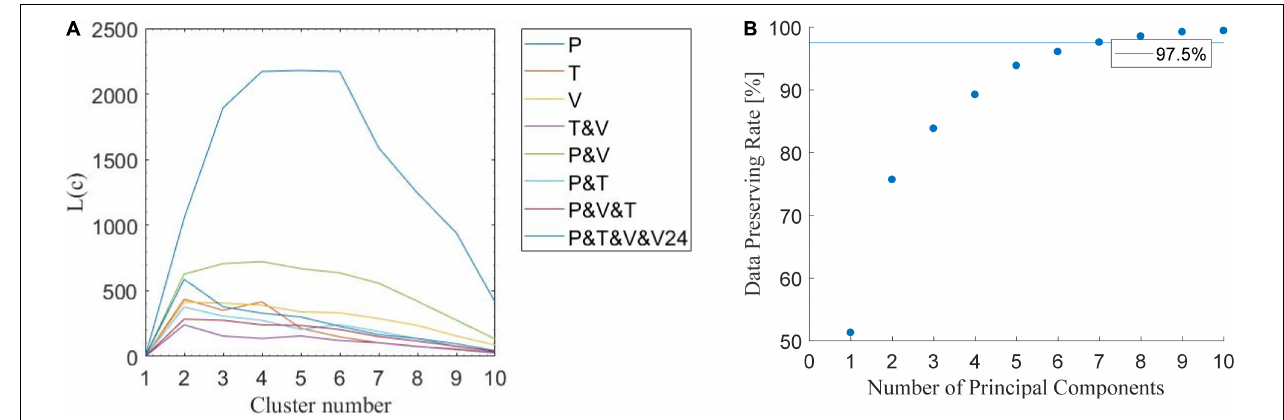
FIGURE 6 | Determine cluster numbers and numbers of principal components. (A) Conventional FCM criteria and their corresponding L(c) values: P (peak discharge value), T (peak time), V (total volume), and V24 (volume in the first 24 h). (B) Data preserving rate in relation to the numbers of principal components. A minimum data-preserving rate of 97.5% was selected as a good representation of the training